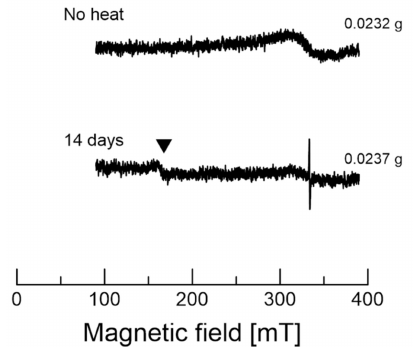
Figure 2. EPR spectra of garlic (top) and black garlic (down) after 14 days of heating. The magnetic field was swept from 90 to 390 mT. The filled triangles indicate the Fe 3 + signal at g ≈ 4.11. Each spectrum was taken at a single